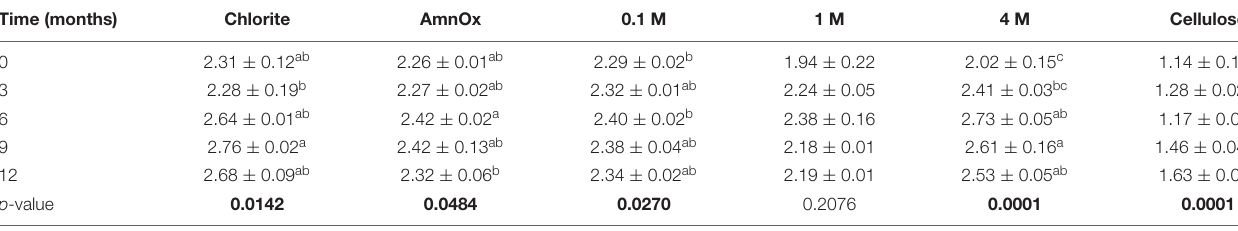
TABLE 3 | Tri: tetrasaccharide ratios in β -glucan of sugarcane straw aging in the field for 12 months. Time (months)